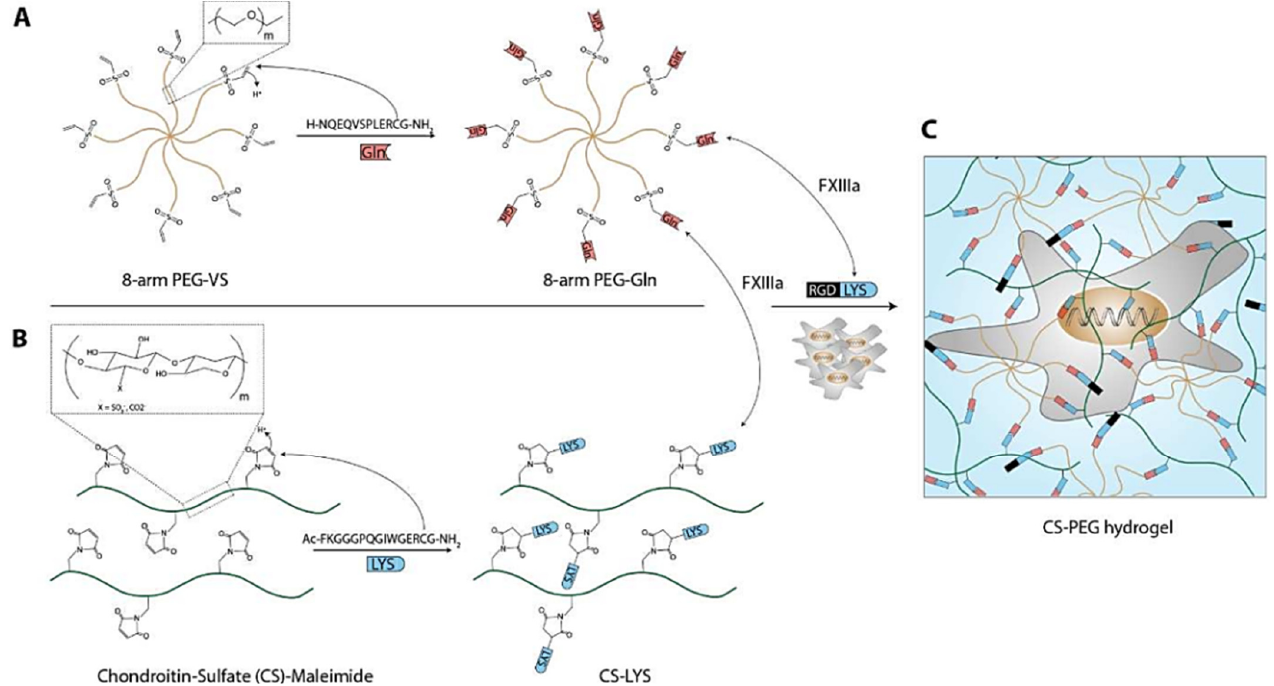
Figure 4. Factor XIII mediated CS-PEG hydrogel formation. The functionalization of ( A ) 8-PEG-VS with TG-Gln peptides resulted in 8-PEG-Gln and ( B ) CS-maleimide with CS-MMP-Lys in CSn-MMP-Lys. ( C ) Formulations of 8-PEG-Gln, CS-MMP-Lys, and the cell adhesion ligand TG-RGD-Lys were crosslinked by FXIIIa in presence of cells to form 3D cellular microenvironments. Reproduced from [89] with permission. Copyright 2016 Elsevier.